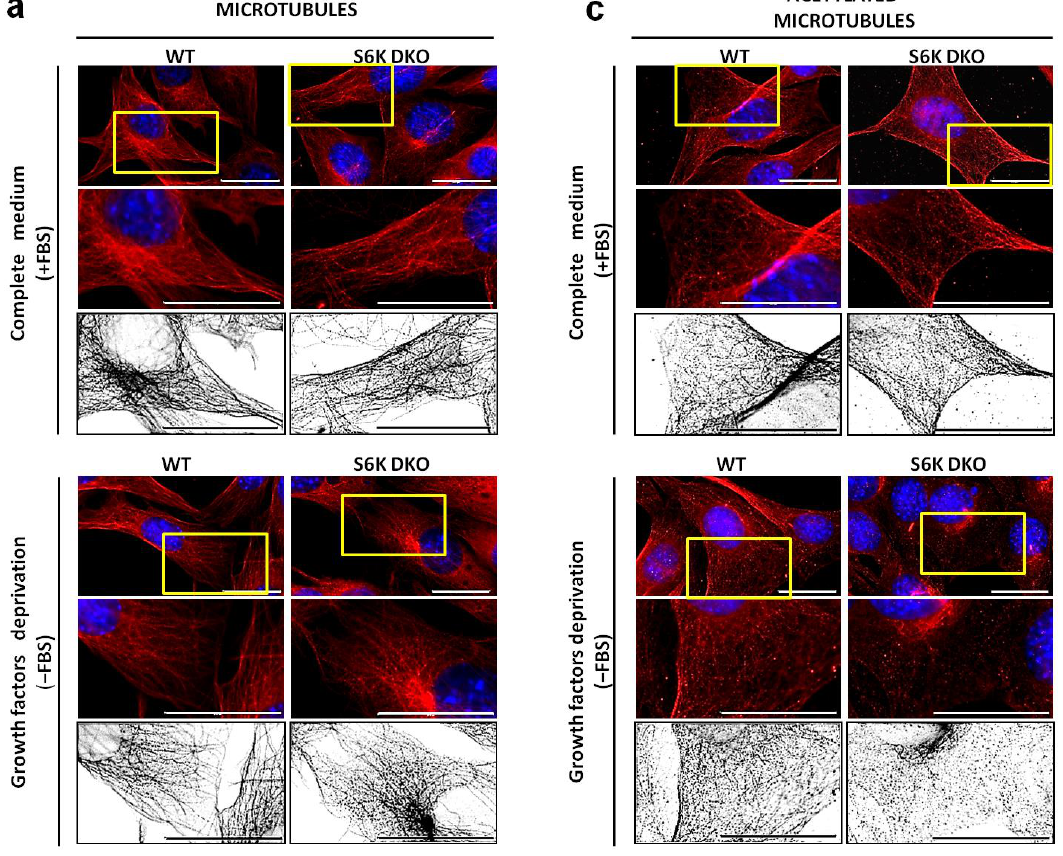
Figure 5. Lack of S6K affects the acetylated but not the total microtubule network in cells deprived of growth factors. Total ( a,b ) and acetylated microtubule network ( c,d ) was investigated by immunofluorescent staining of total α-tubulin ( a ) or acetylated tubulin ( b ), respectively, in WT and S6K DKO (DKO) MEF growing in a complete medium (control; +FBS) or deprived of growth factors (−FBS) for 16 h. The cells were stained using mouse antibodies against α-tubulin ( a ) or acety- lated tubulin (Lys40) ( b ), followed by staining with goat anti-mouse–TRITC conjugates. DNA was stained with DAPI (blue). The indicated sections of original images are enlarged (middle panels), and for clarity, deconvoluted and trans- formed into inverted grey scale (bottom panels). Representative images of cells analyzed in at least 10 random fields per